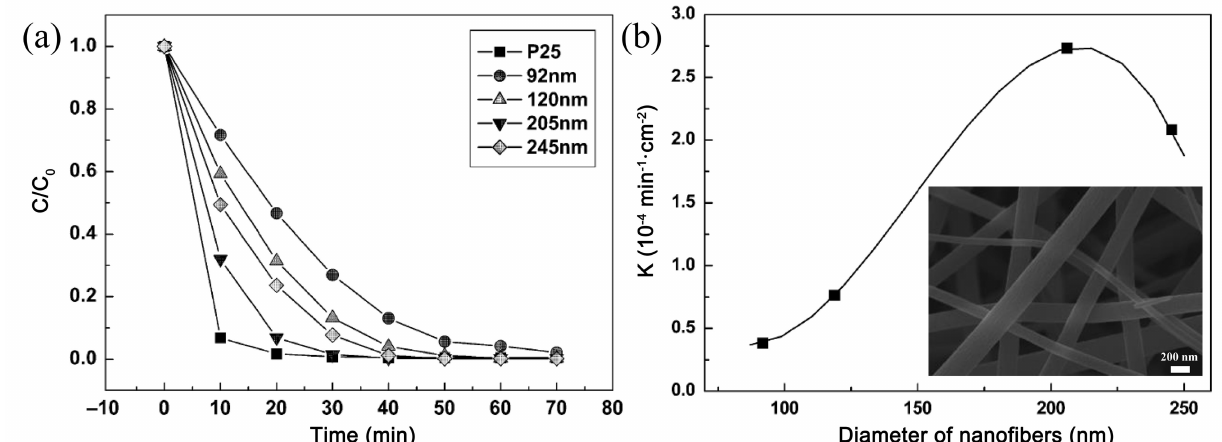
Figure 3. ( a ) Degradation of rhodamine B dye by TiO 2 nanofibers with different diameters under UV light; ( b ) the relationship between the reaction rate constant and the diameter of TiO 2 nanofibers (redrawn with the permission of Ref. [48]. Copyright 2010 John Wiley and